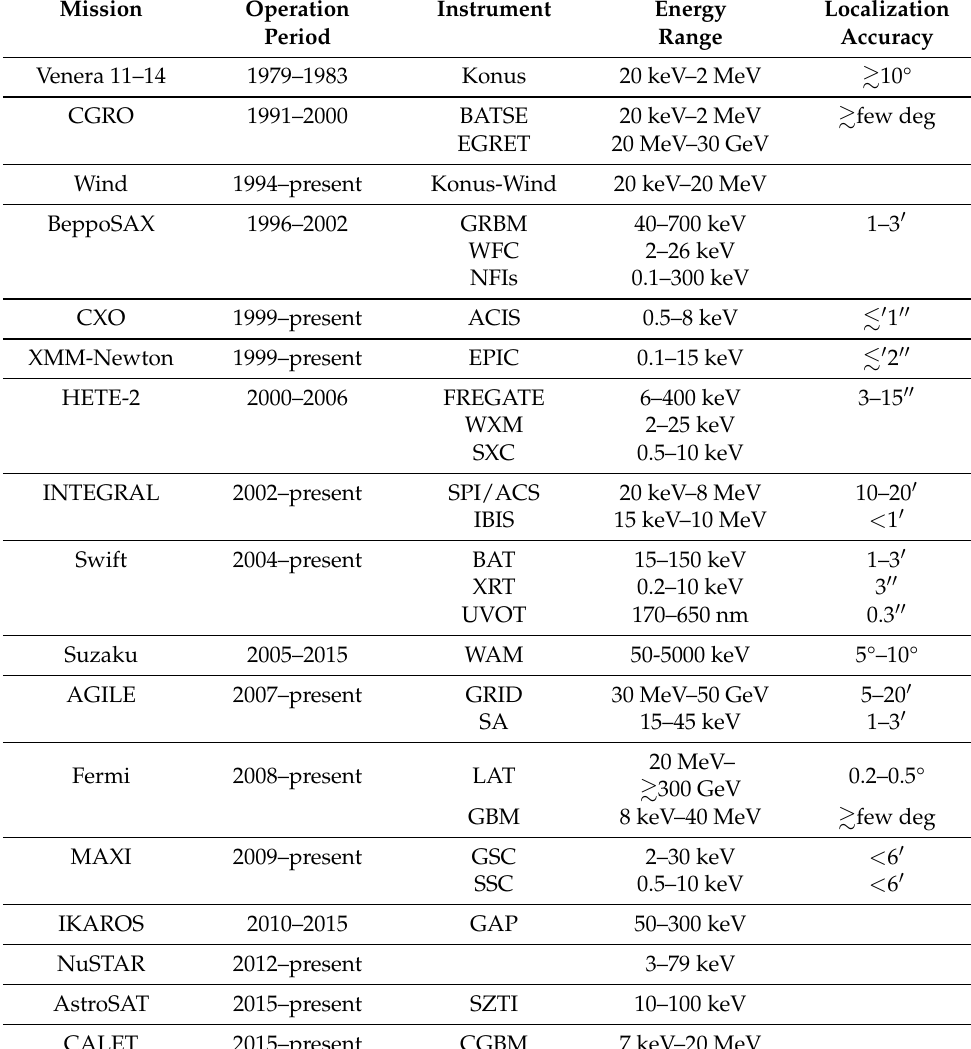
Table 2. Past, present, and future space-based GRB detectors.